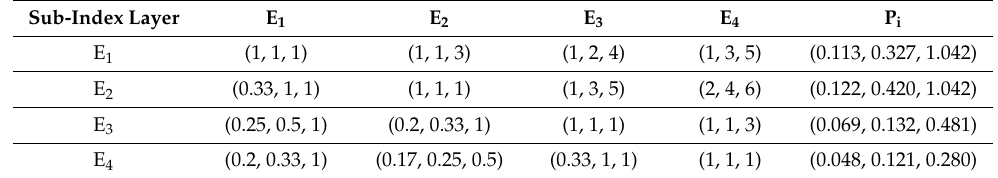
Table 6. Exposure layer weights determined by TFN-AHP.